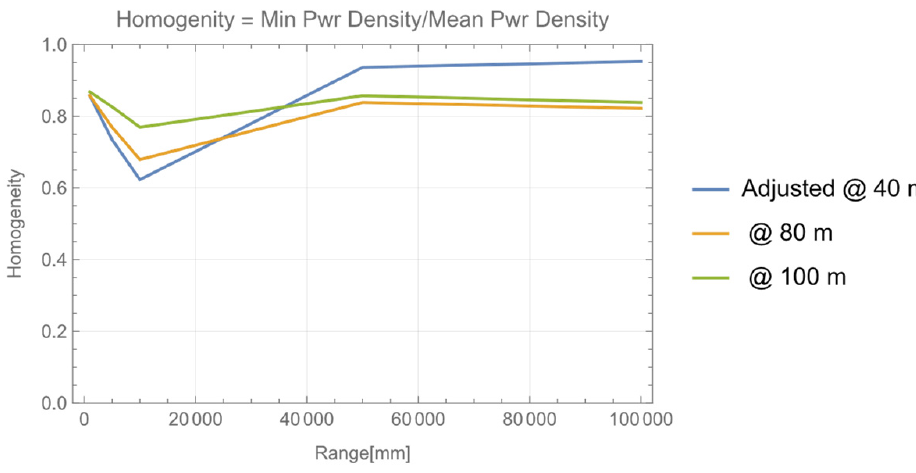
Figure 6. Homogeneity (Min Power Density/Mean Power Density).